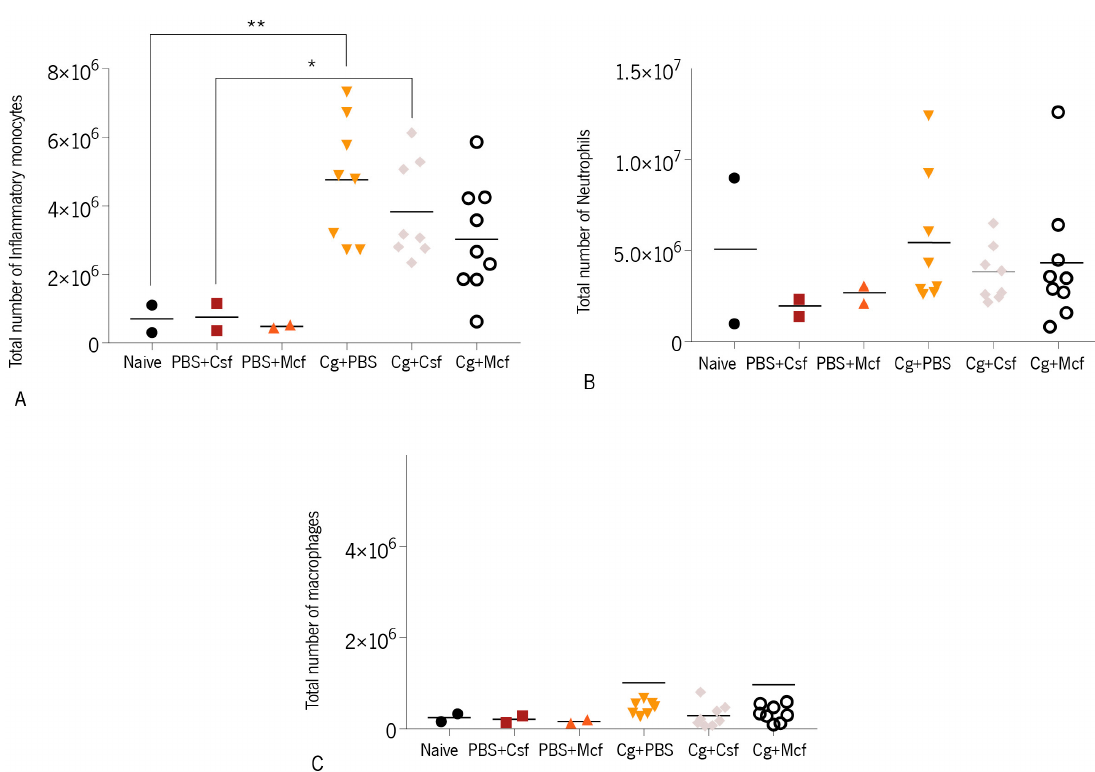
Figure 3. CD1 mice were challenged intravenously with 1 × 10 8 biofilm cells and then treated with PBS, caspofungin (Csf), or micafungin (Mcf). The obtained results are displayed as the total number of cells of indicated populations: ( A ) inflammatory monocytes, ( B ) neutrophils, and ( C ) macrophages. The numbers of animals used were as follows: controls (naïve; PBS + Csf; PBS + Mcf), n = 2; Cg + Csf, n = 8; Cg + Mcf, n = 8. Statistical differences were evaluated using Kruskal–Wallis and post hoc Sidak’s multiple comparison tests (Overall ANOVA P < 0.05). Cg— Candida glabrata ATCC2001. * P < 0.05; ** P < 0.001.